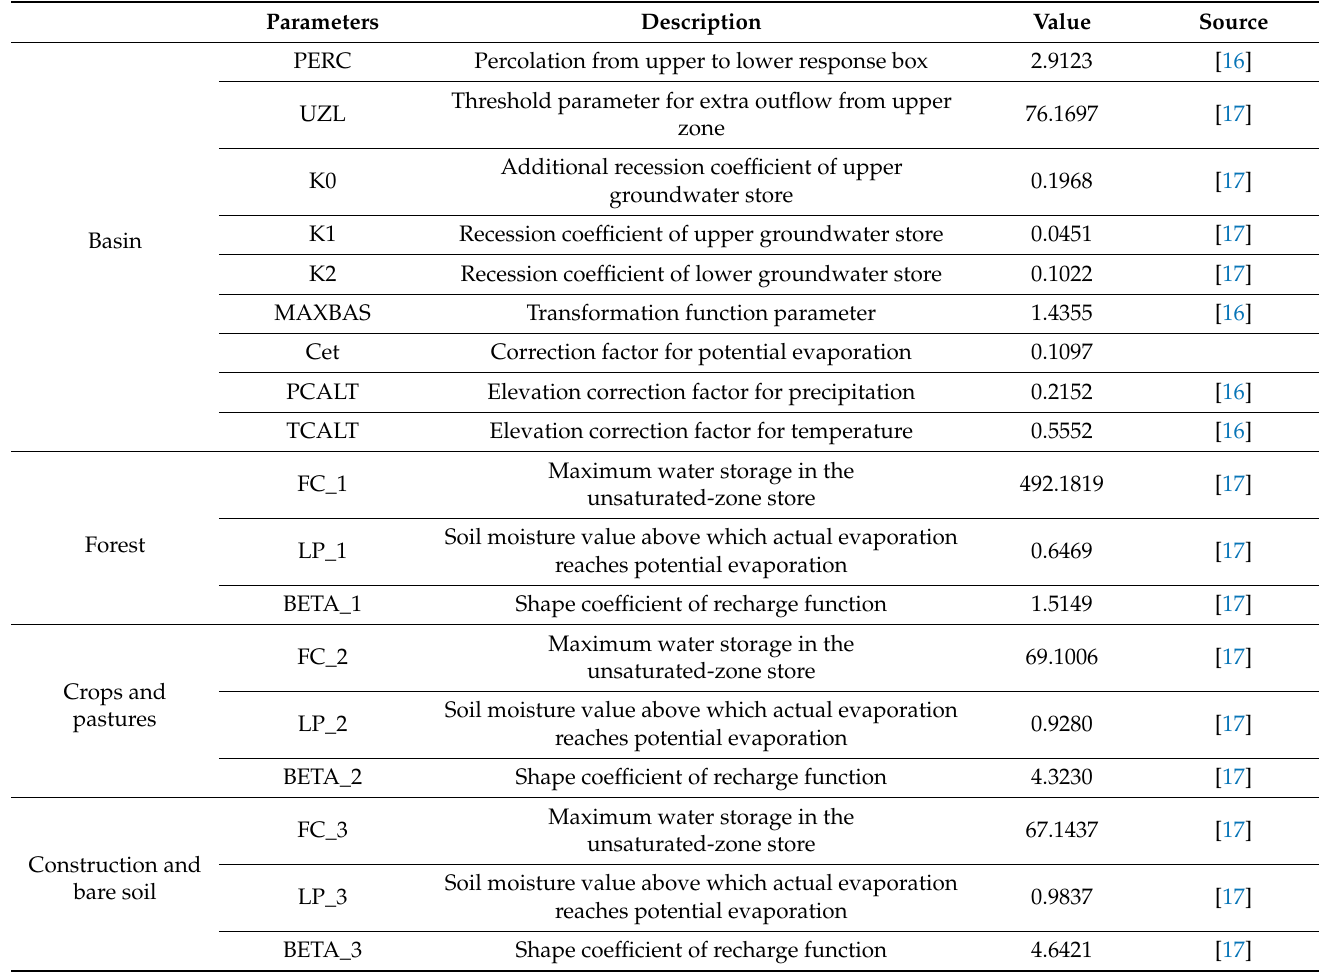
Table 3. HBV model calibration parameters for the basin.